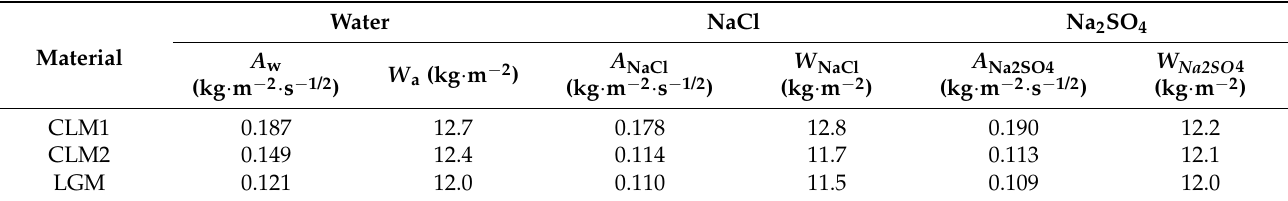
Table 8. The hygric parameters of the researched